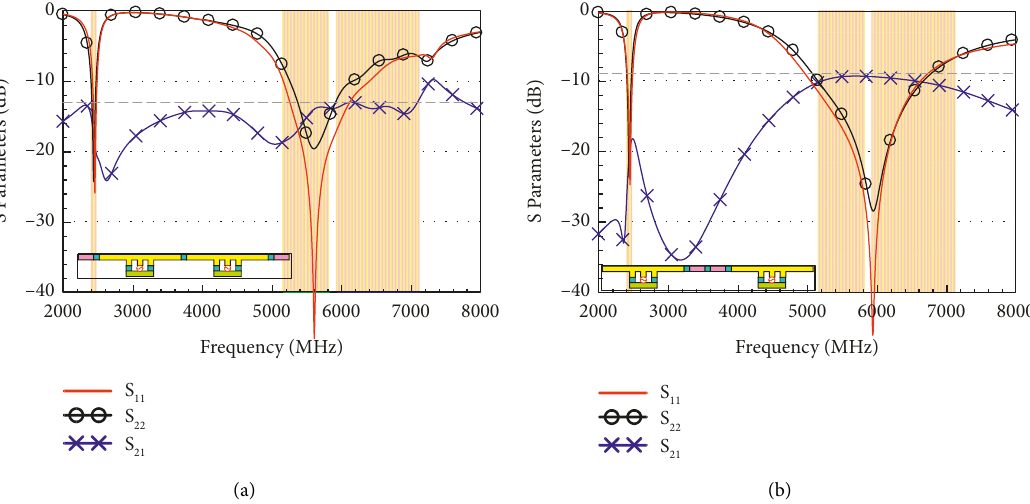
Figure 2: Simulated reflection and transmission coefficients S11 for Ant1, S22 for Ant2, and S21 between two ports for (a) the proposed (5/ 6GHz resonant strips face-to-face) with L 7 � 8.2nH and (b) the reference (2.4GHz resonant strips face-to-face) with L 7 � 91nH.